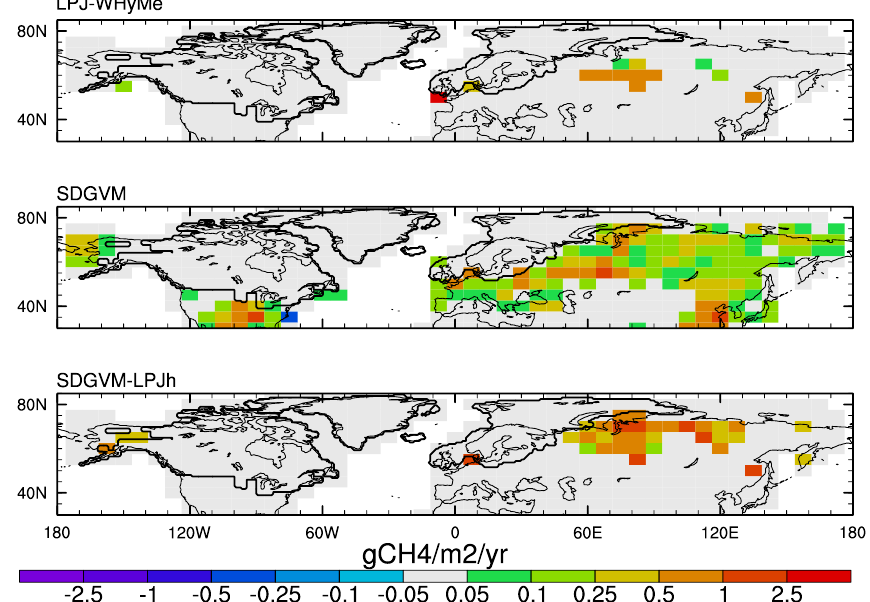
Fig. 8. CH 4 emission anomalies for GI–HS for LGM conditions in LPJ-WHyMe, SDGVM and SDGVM-LPJ-h, including a correction for the fractional land area in coastal grid cells. The distribution of land ice in each simulation is shown by the black contour line.